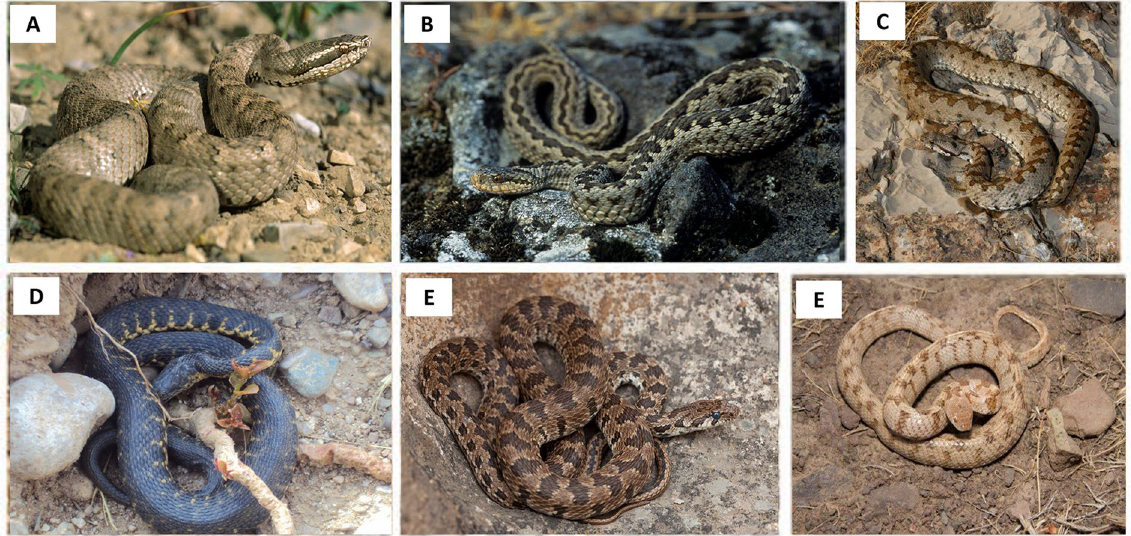
Figure 9. Samples of the images of the six snake species of Lar National Park. A: Caucasian pit viper, venomous; B: Alburzi viper, venomous; C: Latifi’s viper, venomous; D: Dice snake, non-venomous; E: Spotted whip snake, non-venomous; F: European cat snake,